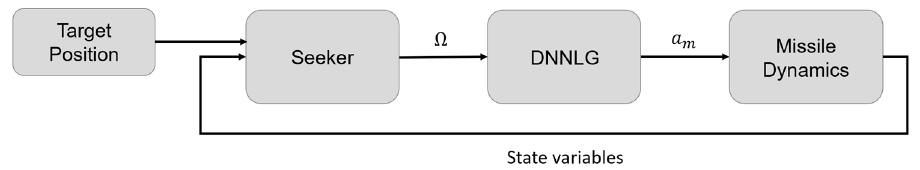
Figure 9. Missile system with DNNLG law.